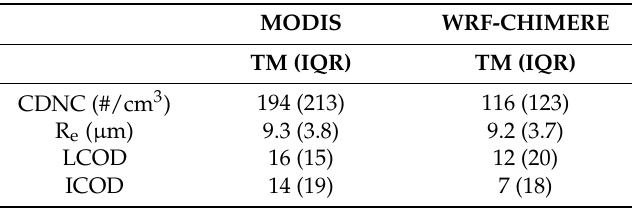
Table 7. Domain trimean (TM) values and interquantile range (IQR) of observed and modelled cloud droplet number concentration (CDNC), droplet effective radius (Re), liquid cloud optical depth (LCOD), and ice cloud optical depth